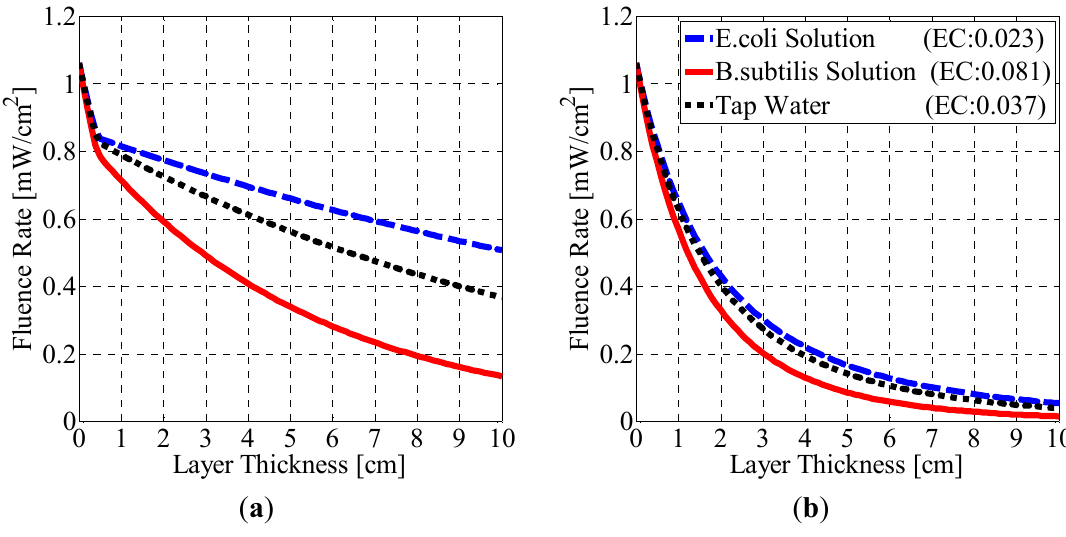
Figure 8. Calculated fluence rate of UVC radiation (280 nm) applying Beer’s law with different extinction coefficients (EC): EC: 0.023 ( E. coli solution), EC: 0.081 ( B. subtilis solution), and EC: 0.037 (tap water). UVC power: 0.97 mW; LED viewing angle: 15° ( a ) with total reflection; ( b ) without total reflection.